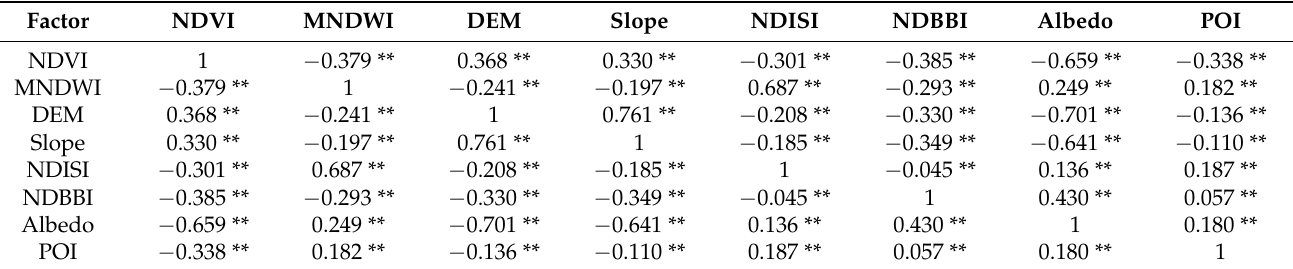
Table 6. Pearson correlation among influencing factors.